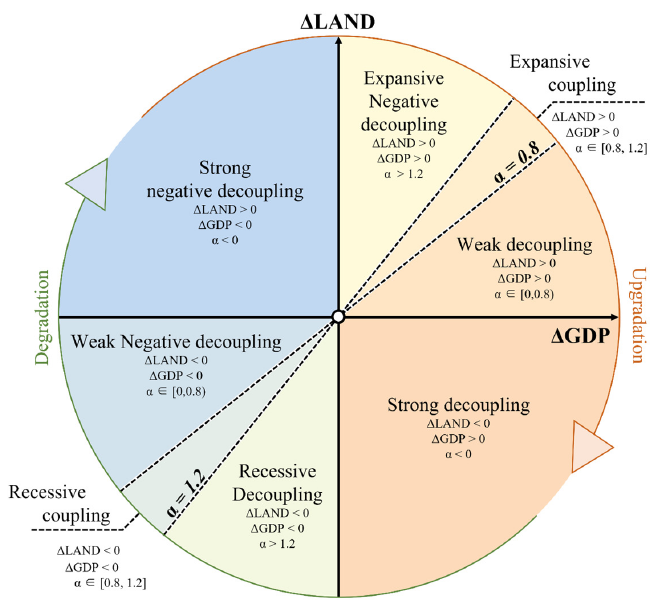
Figure 2. The decoupling relationship between industrial land ( ∆ LAND) and economic development ( ∆ GDP).